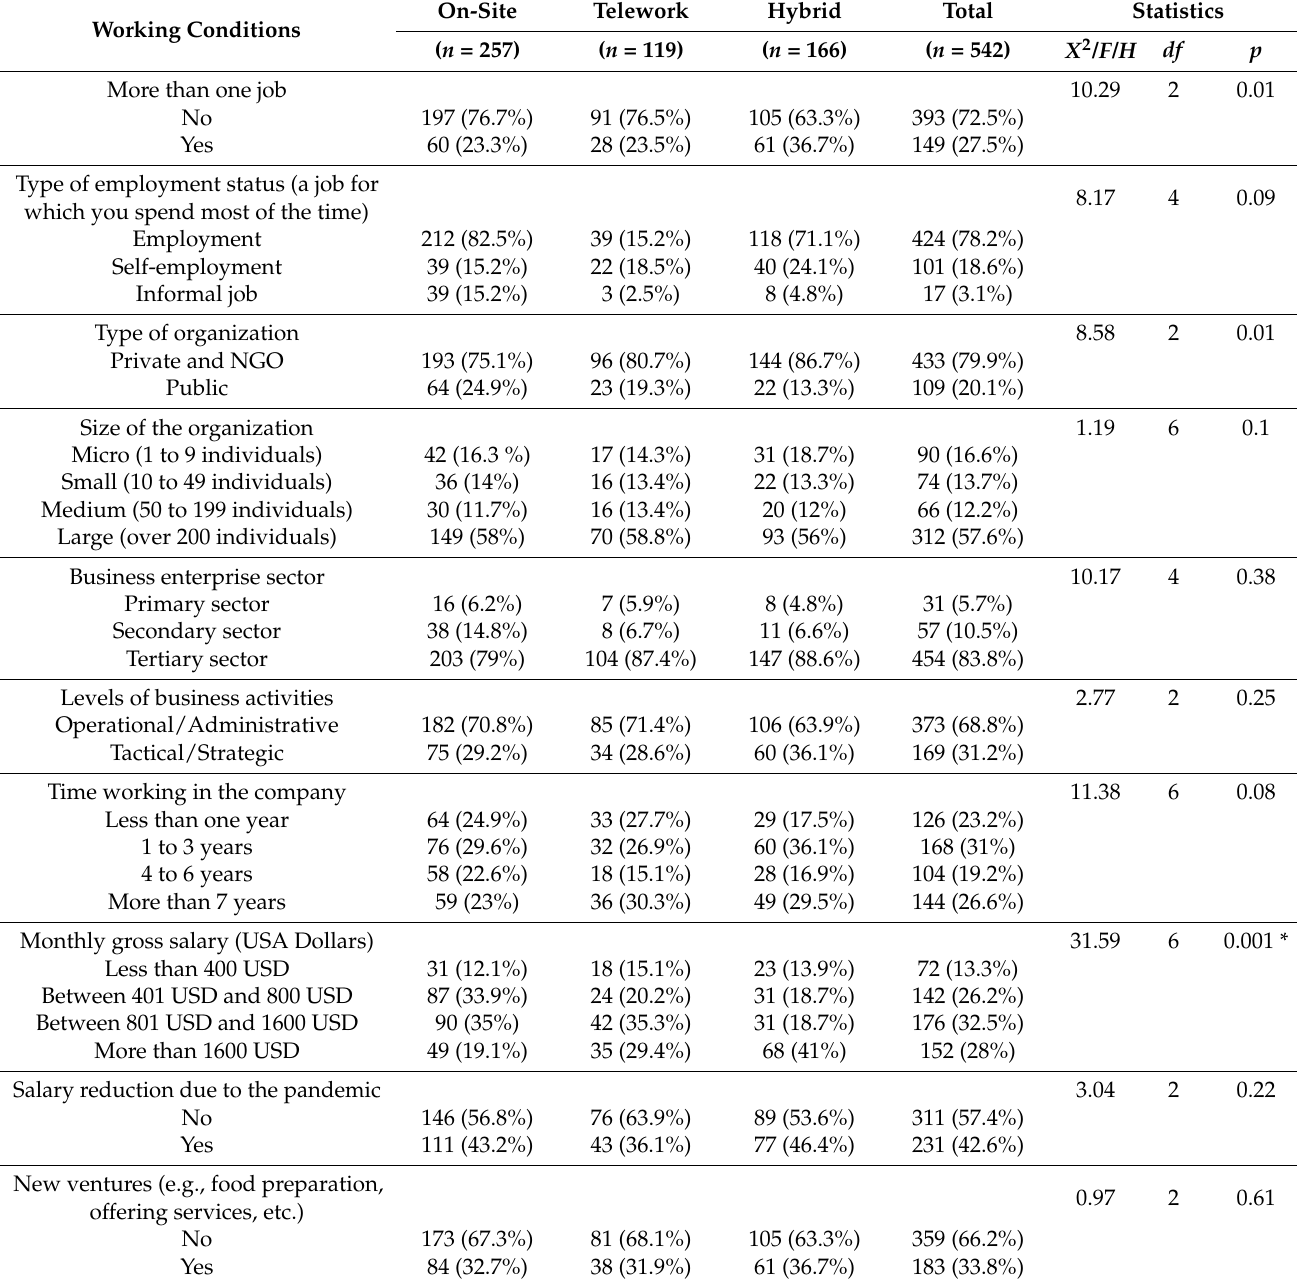
Table 2. Working conditions during the pandemic by working modality and comparison